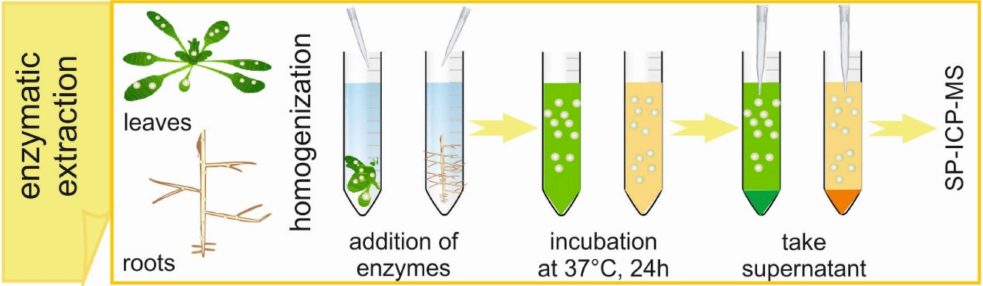
Figure 2. Steps to be performed in a typical enzymatic digestion